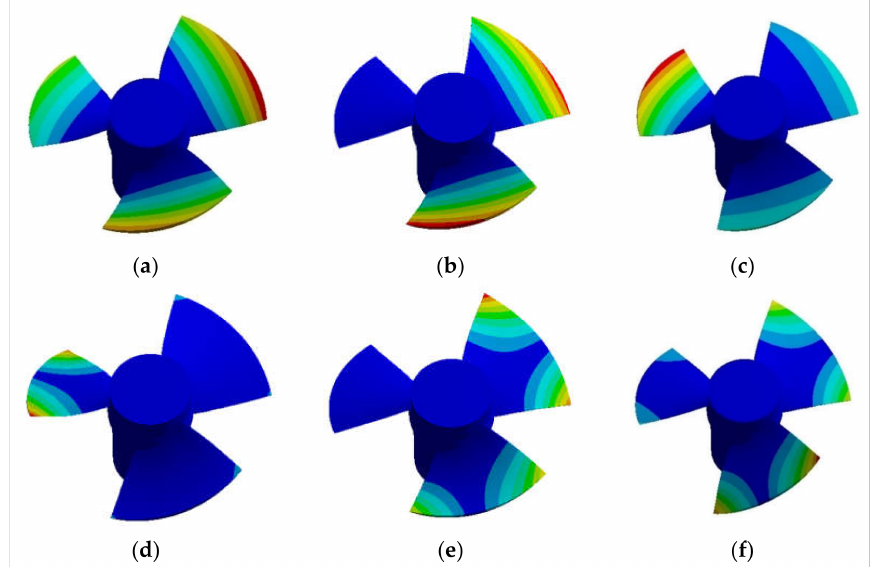
Figure 21. The mode shape changes of scheme I in each mode. ( a ) First-order mode. ( b ) Second-order mode. ( c ) Third-order mode. ( d ) Fourth-order mode. ( e ) Fifth-order mode. ( f ) Sixth-order mode.